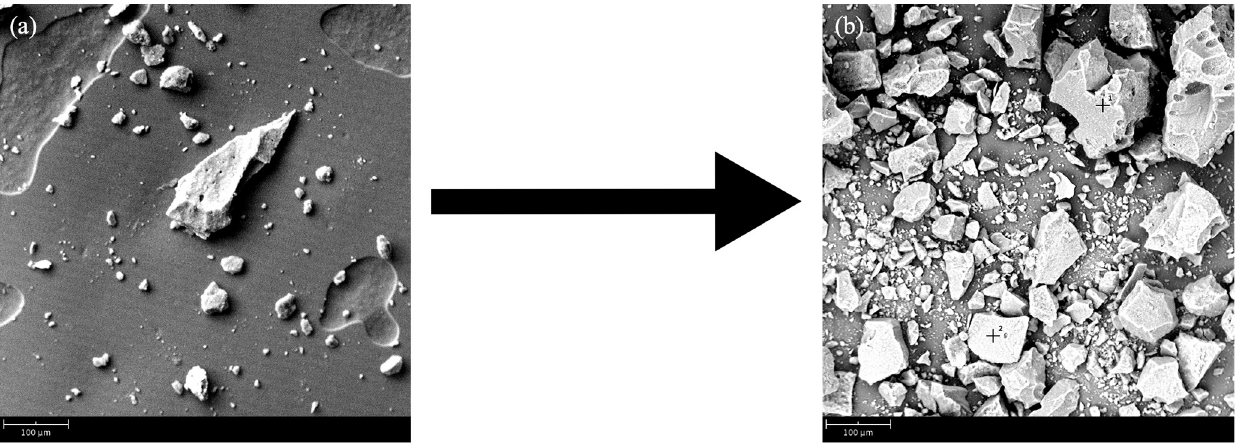
Figure 5. SEM images. ( a ) In this image, obtained from non-heat-treated material, it is possible to observe the inert filler particles involved in the rubber core; ( b ) In this image, obtained from carbonized material at 600 °C, it is possible to observe the inert filler particles after the volatilization of a significant part of the carbon-based materials.